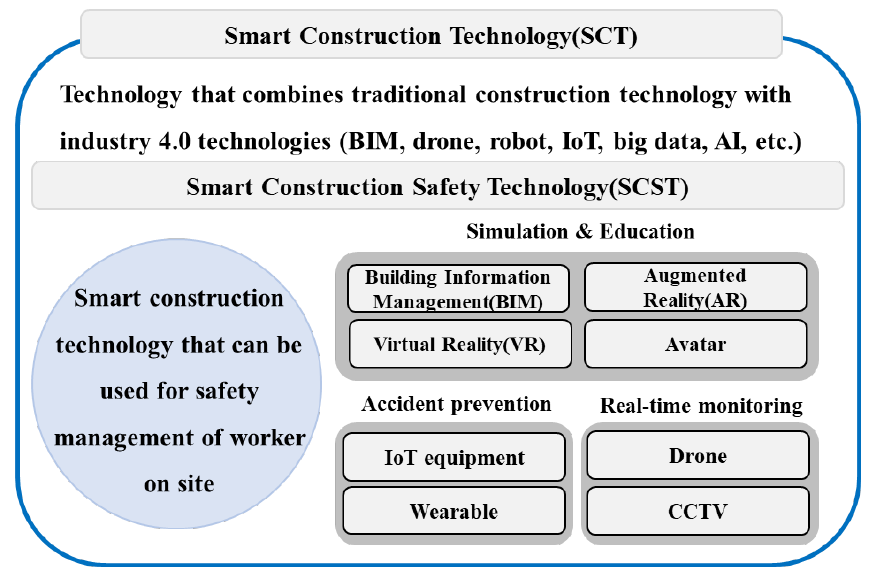
Figure 2. Definitions of SCT and SCSTs (including closed-circuit television (CCTV), building information management (BIM), augmented reality (AR), virtual reality (VR), artificial intelligence (AI), and Internet of Things (IoT)).